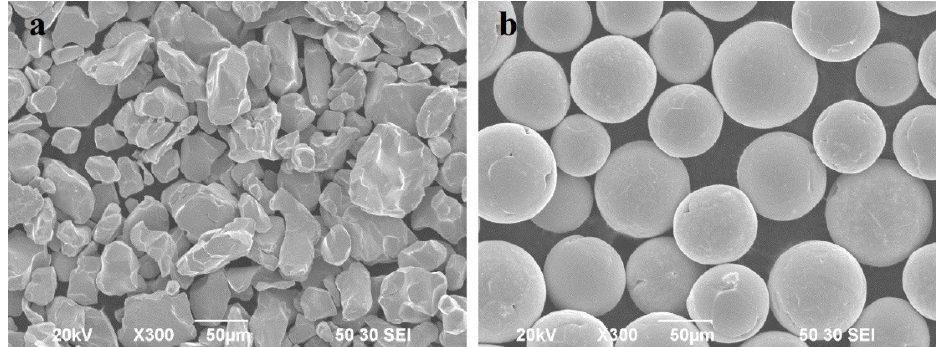
Figure 2. Particle morphology of ( a ) PM-M powder and ( b ) PMS-M99.9 powder.